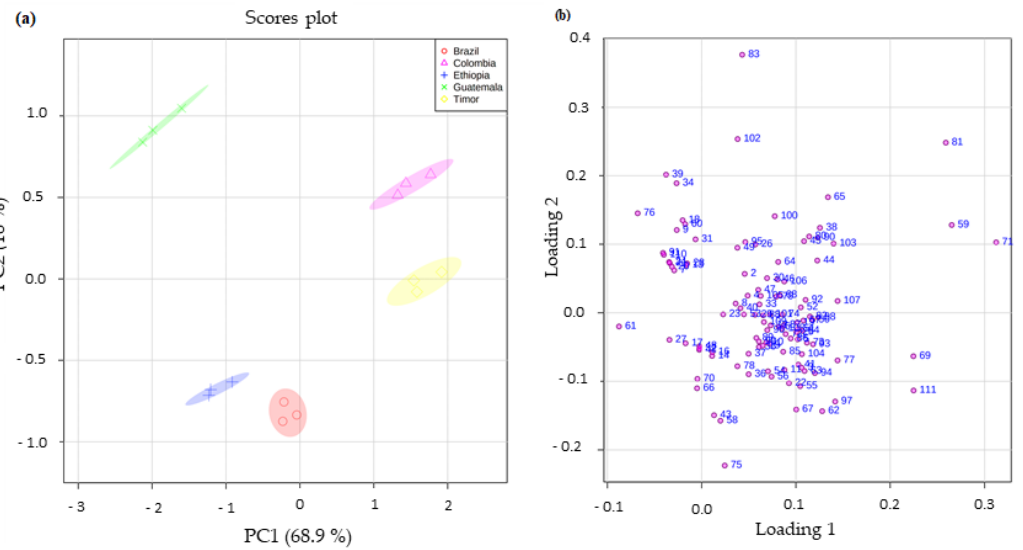
Figure 4. PCA of the volatile fingerprint of spent coffee grounds from different geographical origin. ( a ) PC1 × PC2 score scatter plot and ( b ) loading weight plot (attribution of the peak number is shown in Table 1).